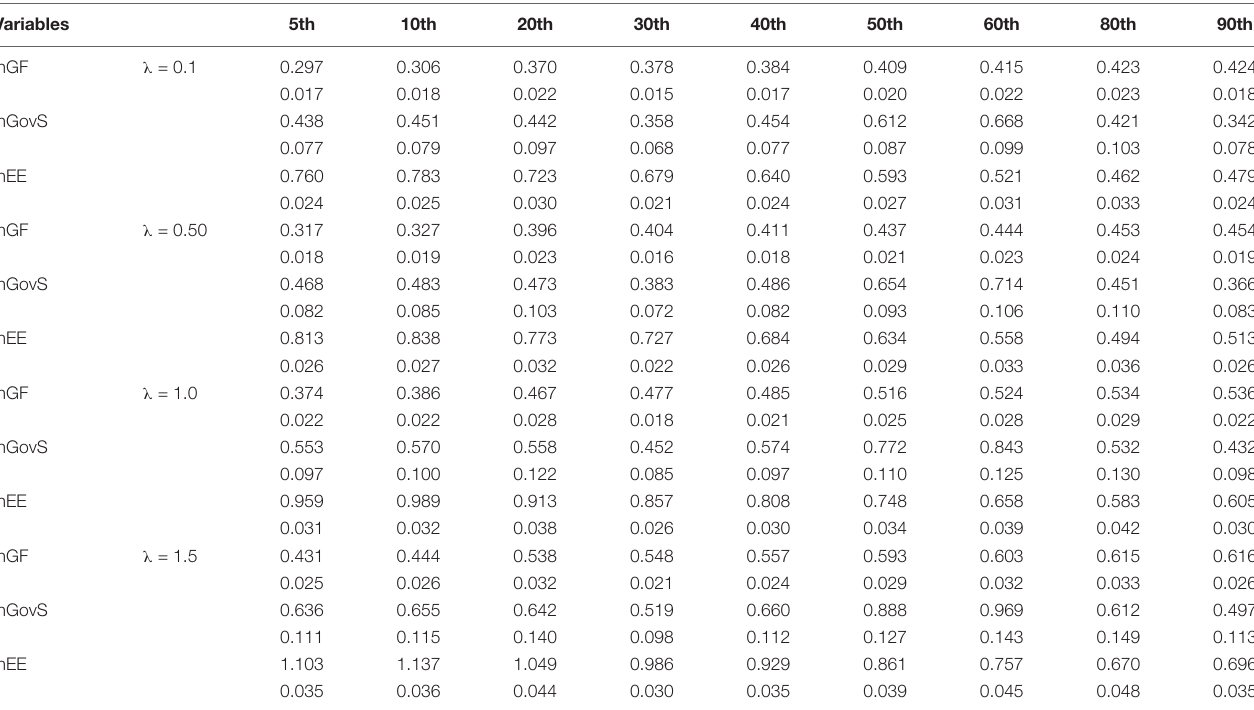
TABLE 8 | Robustness